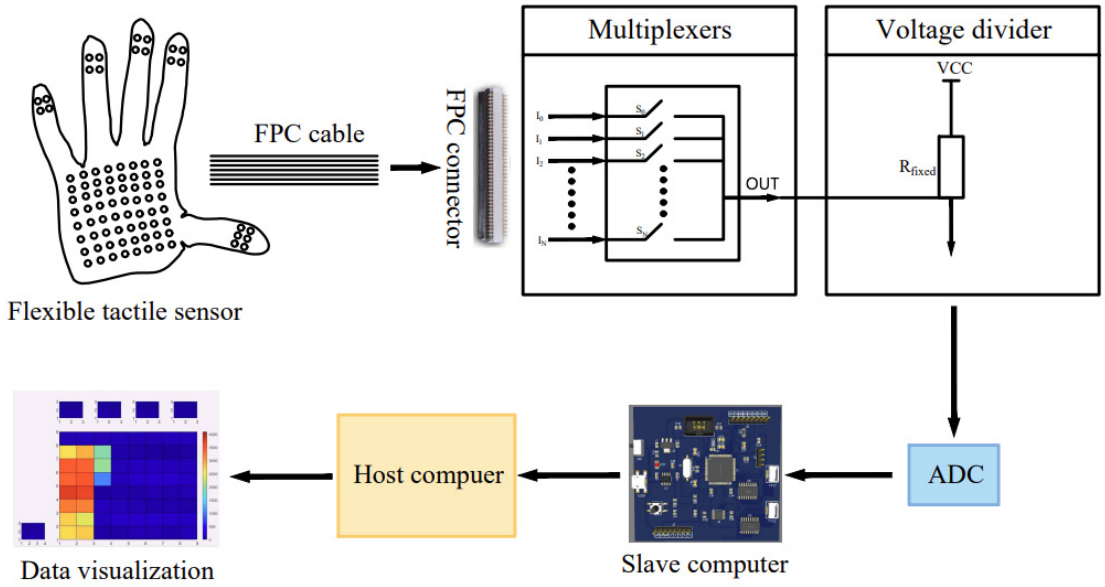
Figure 2. Diagram of the massage data acquisition system.